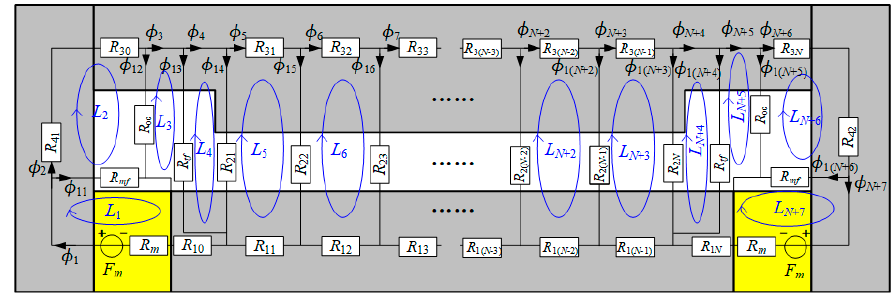
Figure 5. A circular-arc straight-line permeance model of tooth-to-center-yoke flux leakage.